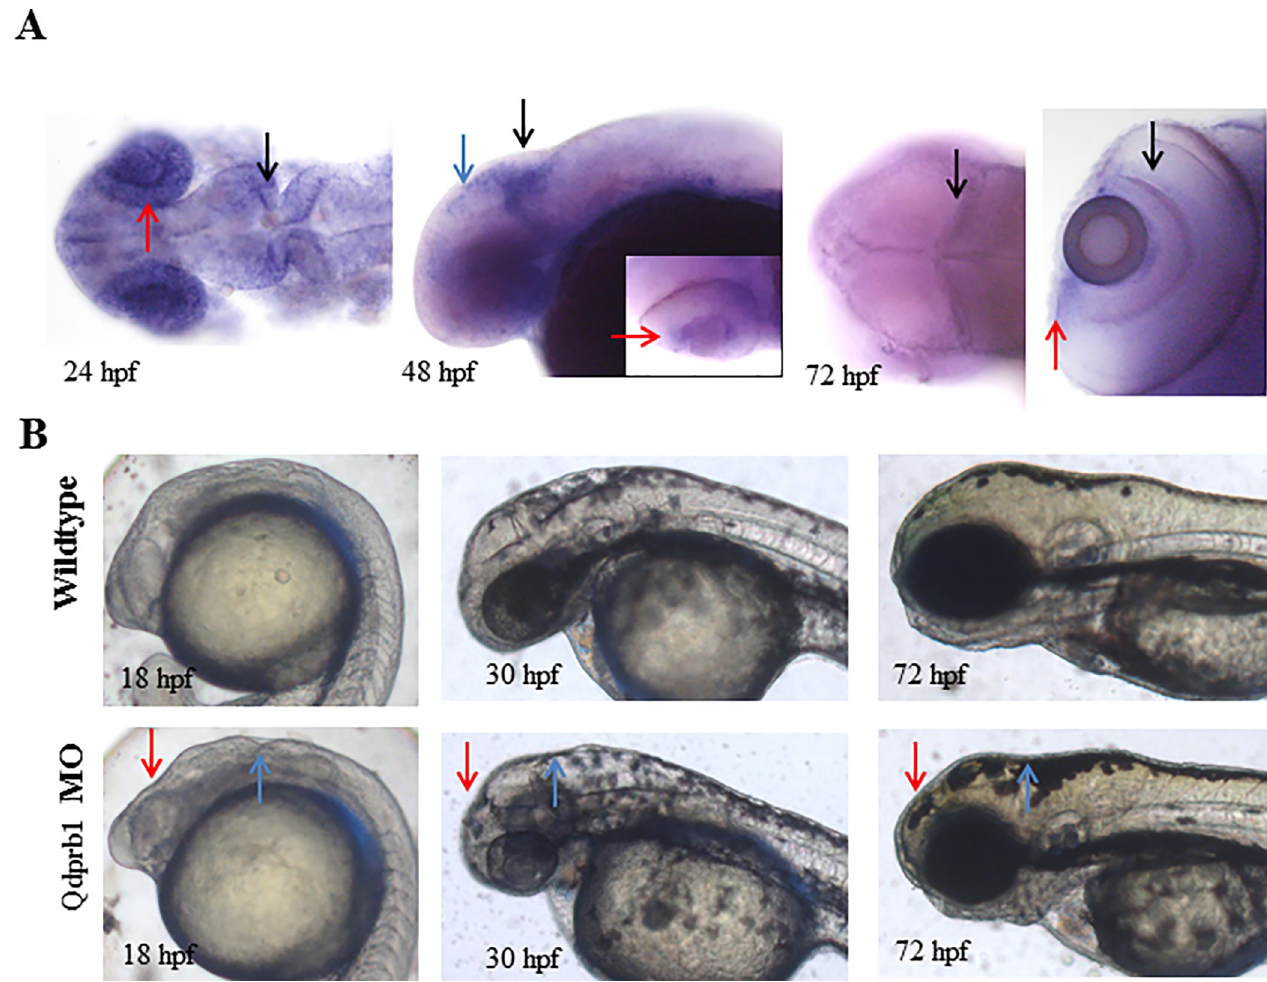
Fig 2. Characterization of Qdprb1. (A) WISH of qdprb1 at 24 hpf (dorsal view, anterior to the left) shows staining in eye (red arrow) and mid-hindbrain boundary (black arrow), at 48 hpf (lateral view, anterior to the left) in the optic tectum (blue arrow) and the mid-hindbrain boundary (black arrow) and CMZ (inset; red arrow, dorsal view, anterior to the left), and at 72 hpf (dorsal view, anterior to the left) in proliferative regions of the optic tectum (black arrow, left picture), CMZ (red arrow, right picture, dorsal view of the eye), as well as inner retinal layer (black arrow). (B) Lateral views, anterior to the left. Comparison of wildtype embryos at 18 hpf, 24 hpf and 72 hpf and qdprb1 hypomorphic embryos exhibit abnormal midbrain (red arrow) and anterior hindbrain (blue arrow) morphology and microcephaly.